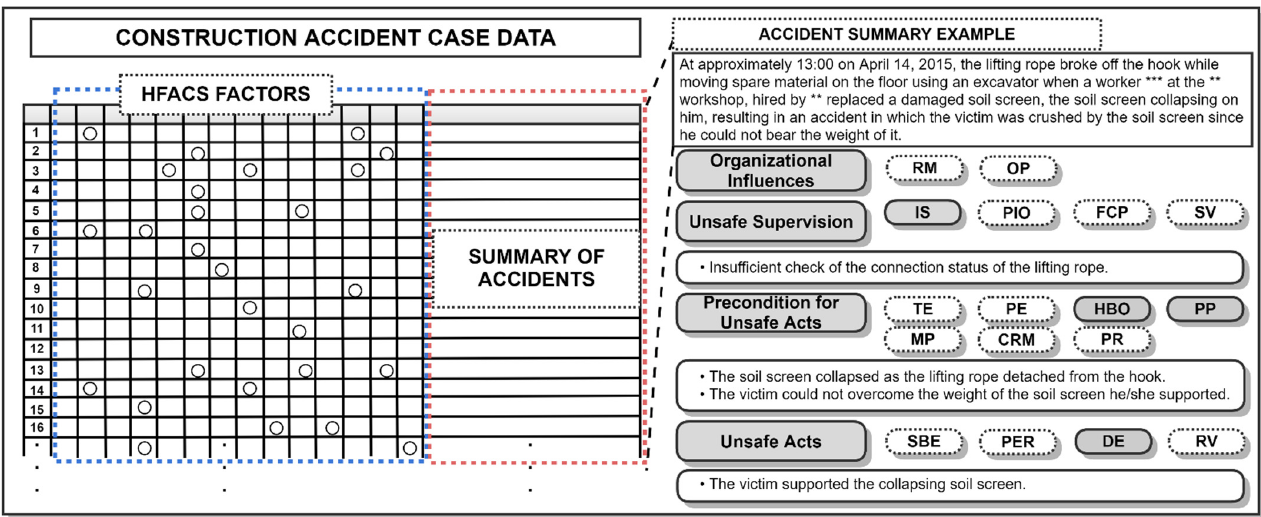
Figure 2. Example of the HFACS factor classification method.